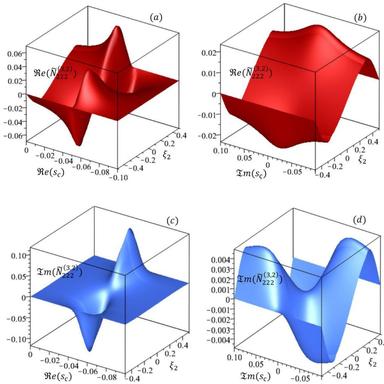
(a) Dimensionless real part of the perturbation function N˜(3,2) 222 , Re(N˜(3,2) 222 ), vs. Re(sς ) and the coordinate ξ 2. (b) Dimensionless real part Re(N˜(3,2) 222 ) vs. Im(sς ) and ξ 2. (c) Dimensionless imaginary part Im(N˜(3,2) 222 ) vs. Re(sς ) and ξ 2. (d) Dimensionless imaginary part Im(N˜(3,2) 222 ) vs. Im(sς ) and ξ 2, obtained for rρ = 10, rE = 10, τ i ς = 10, i = 1, 2, ν˜1 = ν˜2 = 0.2, η = 1 and γ = 1.